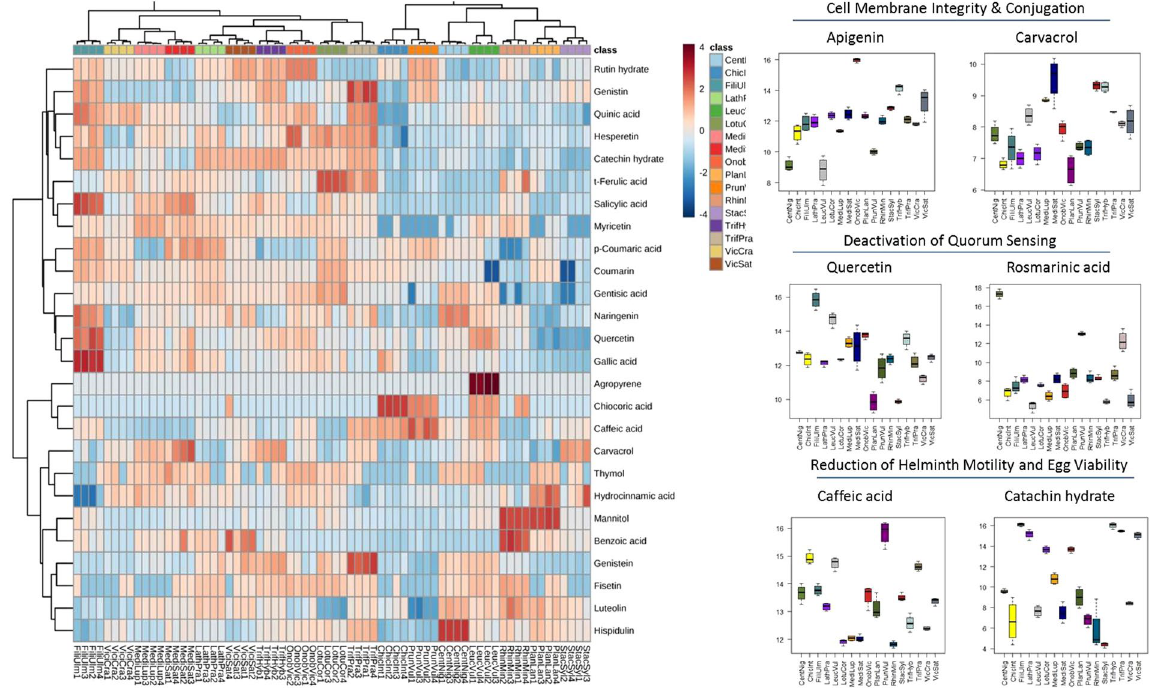
Figure 2. Heat map of 31 antimicrobial and anthelmintic compounds found across 17 grassland plants. These compounds perform a diverse array of functions, including targeting microbial cell membrane integrity and conjugation in bacteria, disrupting quorum sensing, and reducing the motility and fertility of intestinal worms. Samples from each plant are identified as the first four letters of the genus and first three letters of the species according to Linnean classification. Compound concentrations are represented on a log